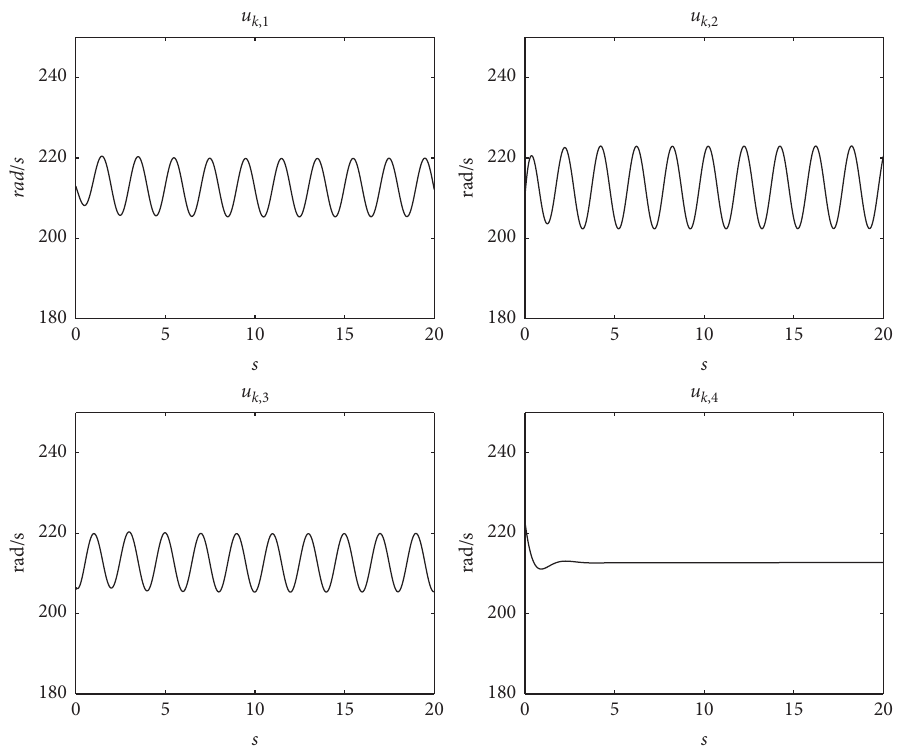
Figure 7: Rotors frequencies for minimum randomness tracking.